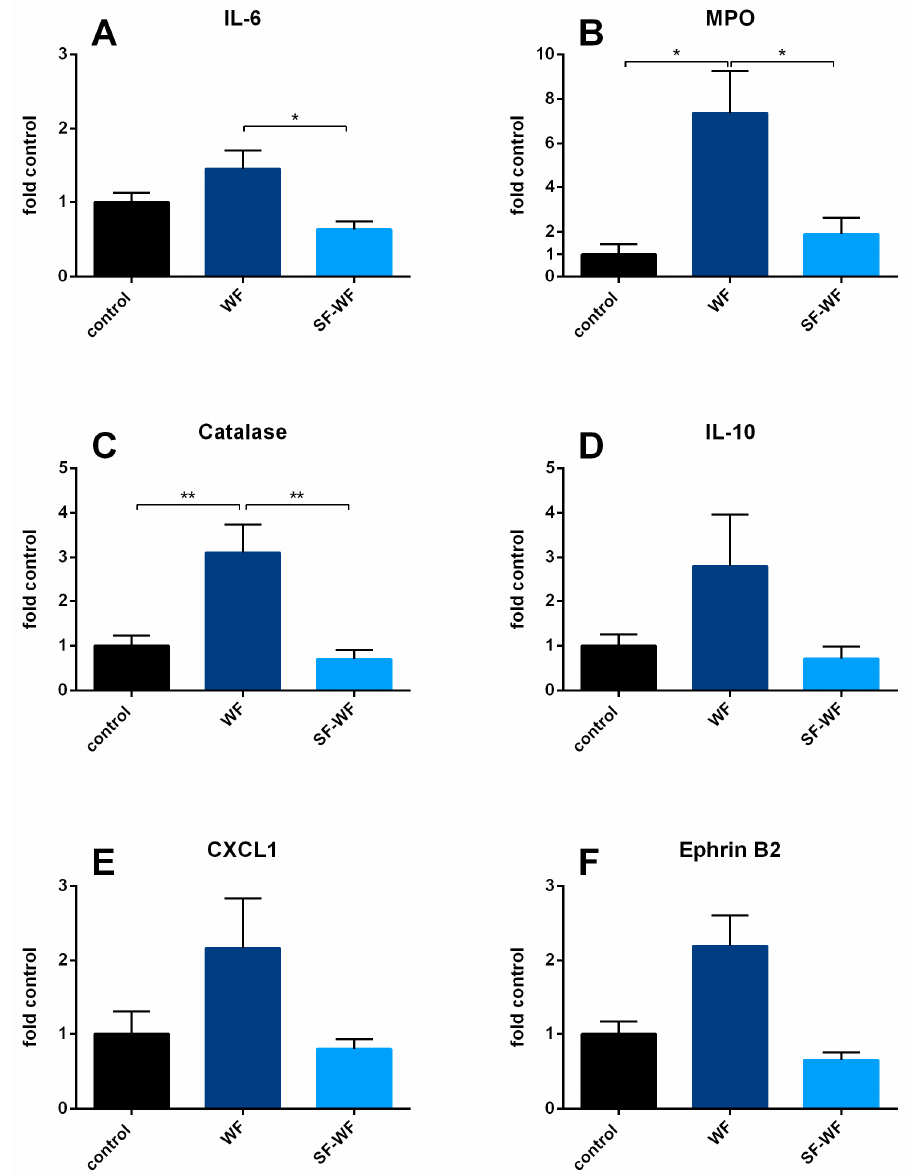
Figure 5. Influence of welding fume instillation: mRNA expression of isolated perfused lungs. ( A ): IL-6 mRNA expression levels (mean ± SEM), ( B ): MPO mRNA expression levels (mean ± SEM), ( C ): catalase mRNA expression levels (mean ± SEM), ( D ): IL-10 mRNA expression levels (mean ± SEM), ( E ): CXCL-1 mRNA expression levels (mean ± SEM), ( F ): EphrinB2 mRNA expression levels (mean ± SEM), control and WF n = 6, SF-WF n = 5. * = p < 0.05, ** = p < 0.01.